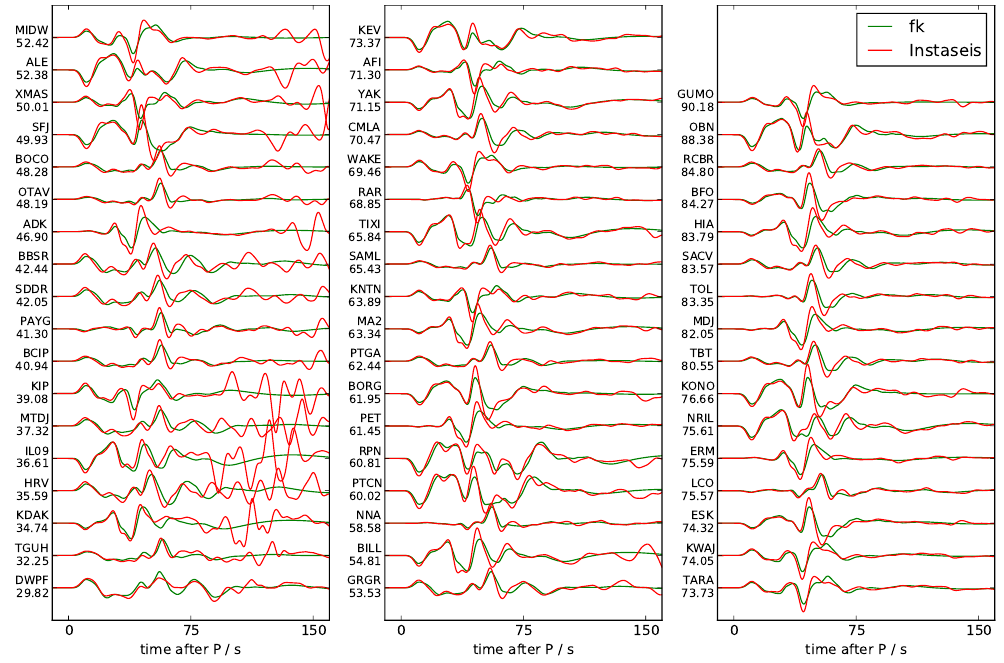
Figure 21. Seismograms for the SIV benchmark, Z-component aligned on the P arrival band-pass filtered between 5 and 100s period. The labels denote the station code and epicentral distance. In the frequency–wave number integration (fk, Kikuchi and Kanamori, 1982), only direct P and the depth phases were included, while Instaseis provides full seismograms, including PP, PcP and other phases. Especially for the stations in less than 40 ◦ distance, the effect is profound, since PP arrives as a triplicated complex wave train only 70–100s after P. Due to the long source duration, the PP arrival overlaps with the direct P wave train for several stations.